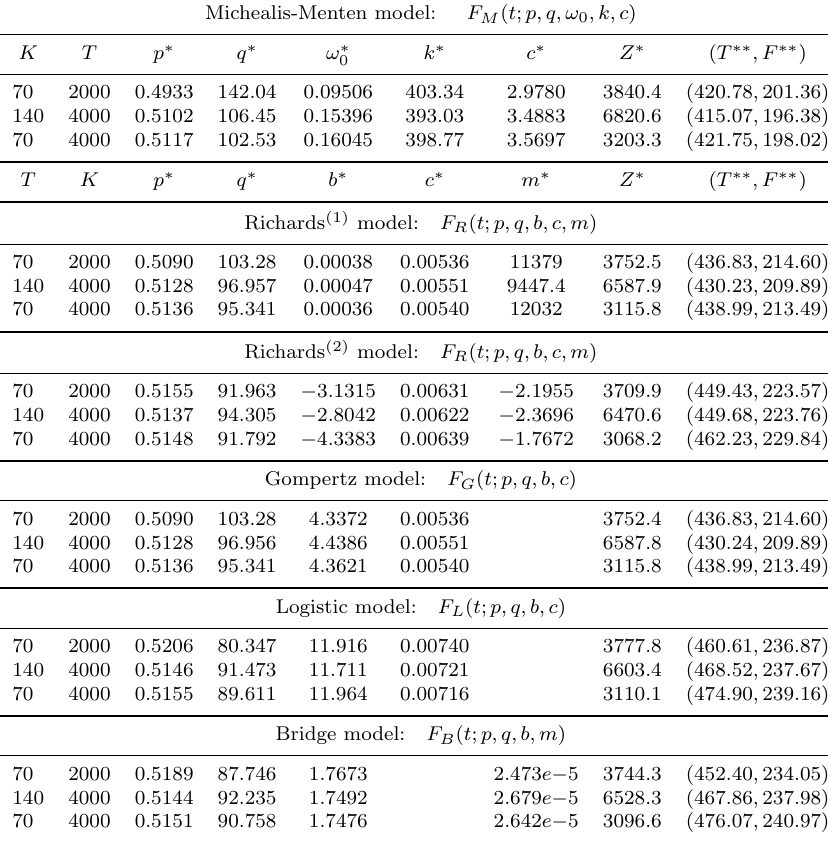
Table 3. Optimal parameters, optimal value and an approximation of the inflection point ( T ∗∗ ,F ∗∗ ) for each data set ( K,T ).